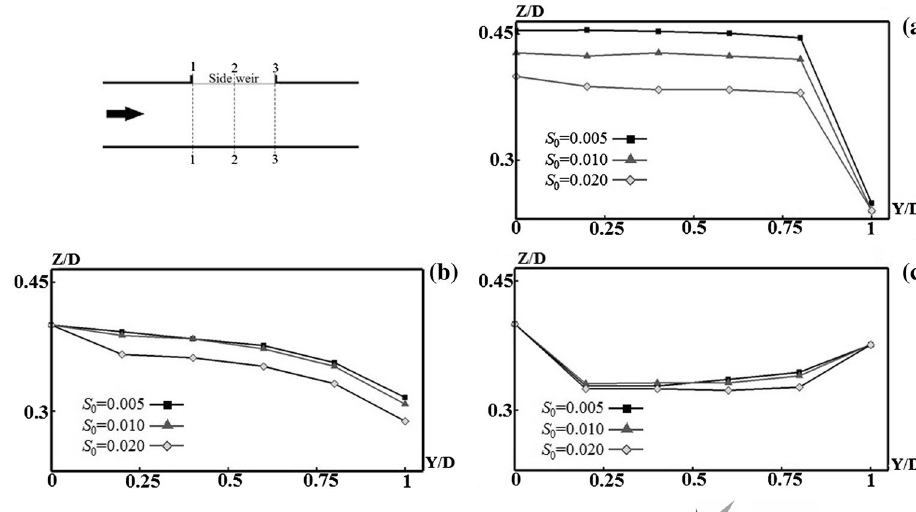
Fig. 7 Transverse profiles of simulated free surface for various slopes a section 1-1, b section 2-2, c section